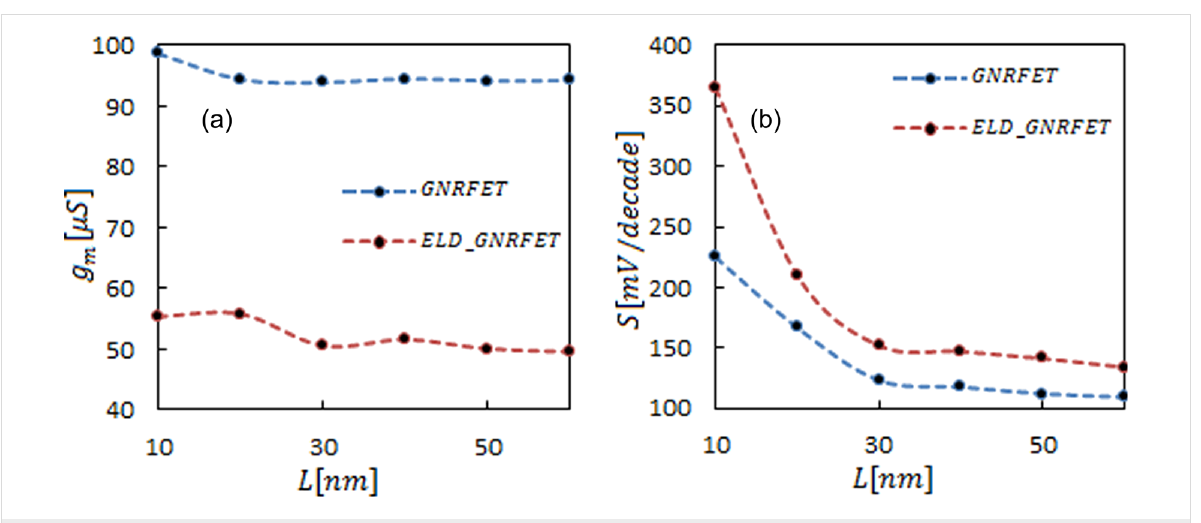
Figure 4: Comparison between average of (a) transconductance and (b) subthreshold swing of ELD-GNRFET and GNRFET as a function of the channel length. The lines are a guide to the